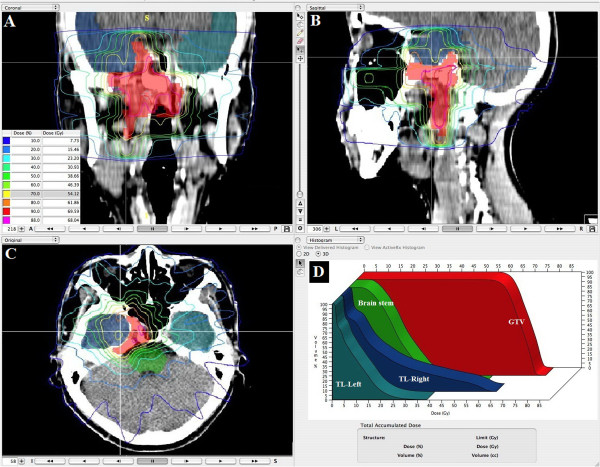
Isodose curves for an IMRT plan are shown. The patient had a T4N1M0 cacinoma of the nasopharynx as seen on the coronal (A), sagittal (B), and axial (C) planes. The dose-volume histograms for relevant structures are shown (D).